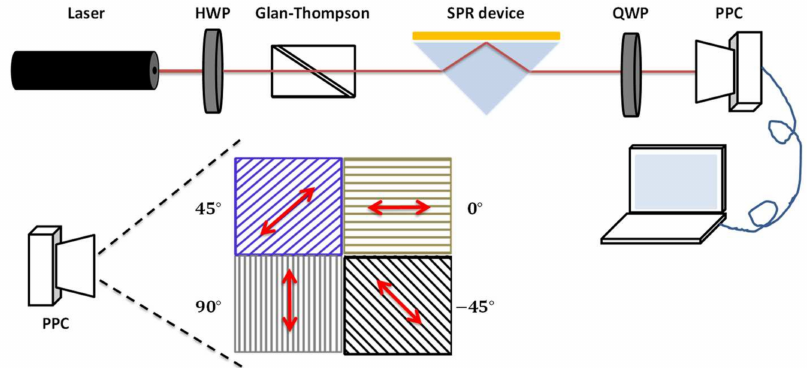
Figure 1. Schematic illustration of the phase-sensitive SPR based on simultaneous polarization measurement with common-path interferometry. HWP: half-wave plate, QWP: quarter-wave plate, PPC: pixelated polarization